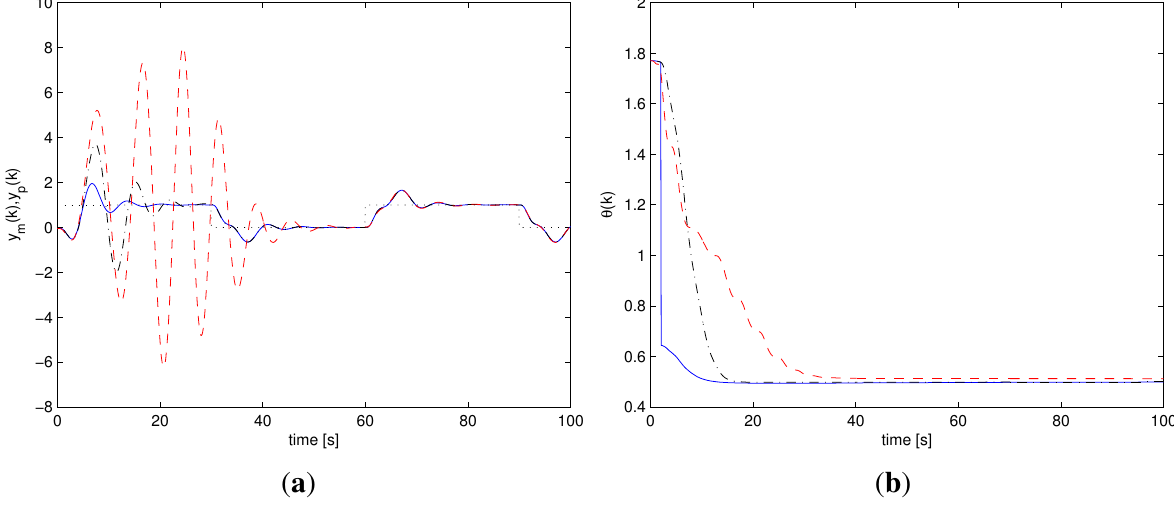
Figure 5. Unmodeled dynamics, θ ∗ = 0 . 5 : Multi-AMC (solid), AMC (dash-dotted), APPC (dashed). ( a ) output response y ( t ) : Multi-AMC (solid), AMC (dash-dotted), APPC (dashed); ( b ) Parameter estimate θ ( t ) : Multi-AMC (solid), AMC (dash-dotted), APPC